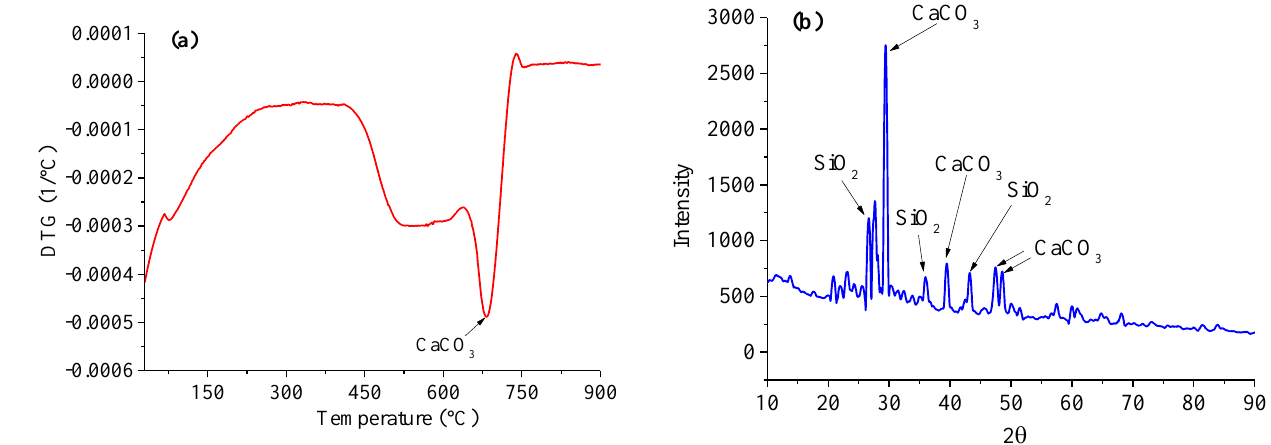
Figure 8. ( a ) DTG curves and ( b ) the XRD patterns of the carbonated mortar sample.